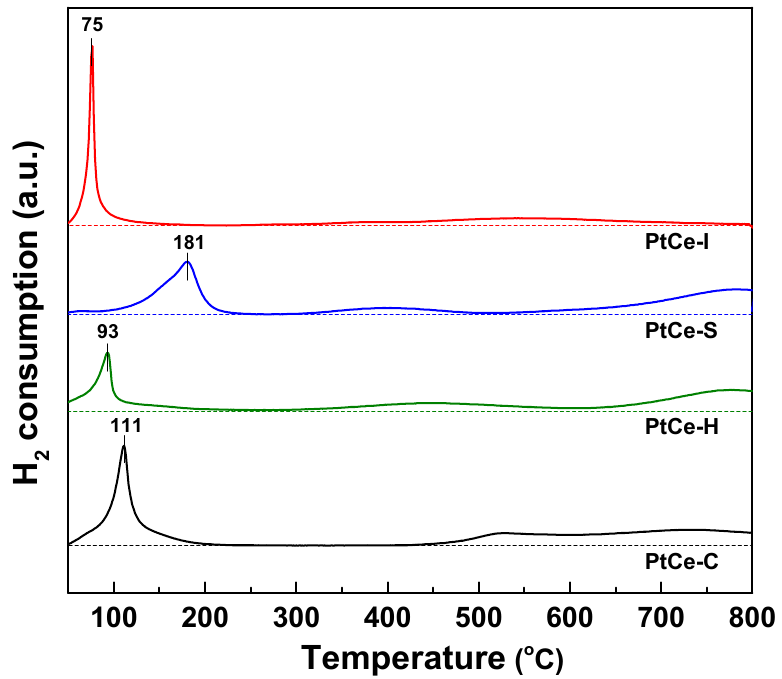
Figure 2. H 2 -TPR profiles of CeO 2 -supported Pt catalysts prepared by various synthesis Figure 2. H 2 ‐ TPR profiles of CeO 2 ‐ supported Pt catalysts prepared by various synthesis methods.